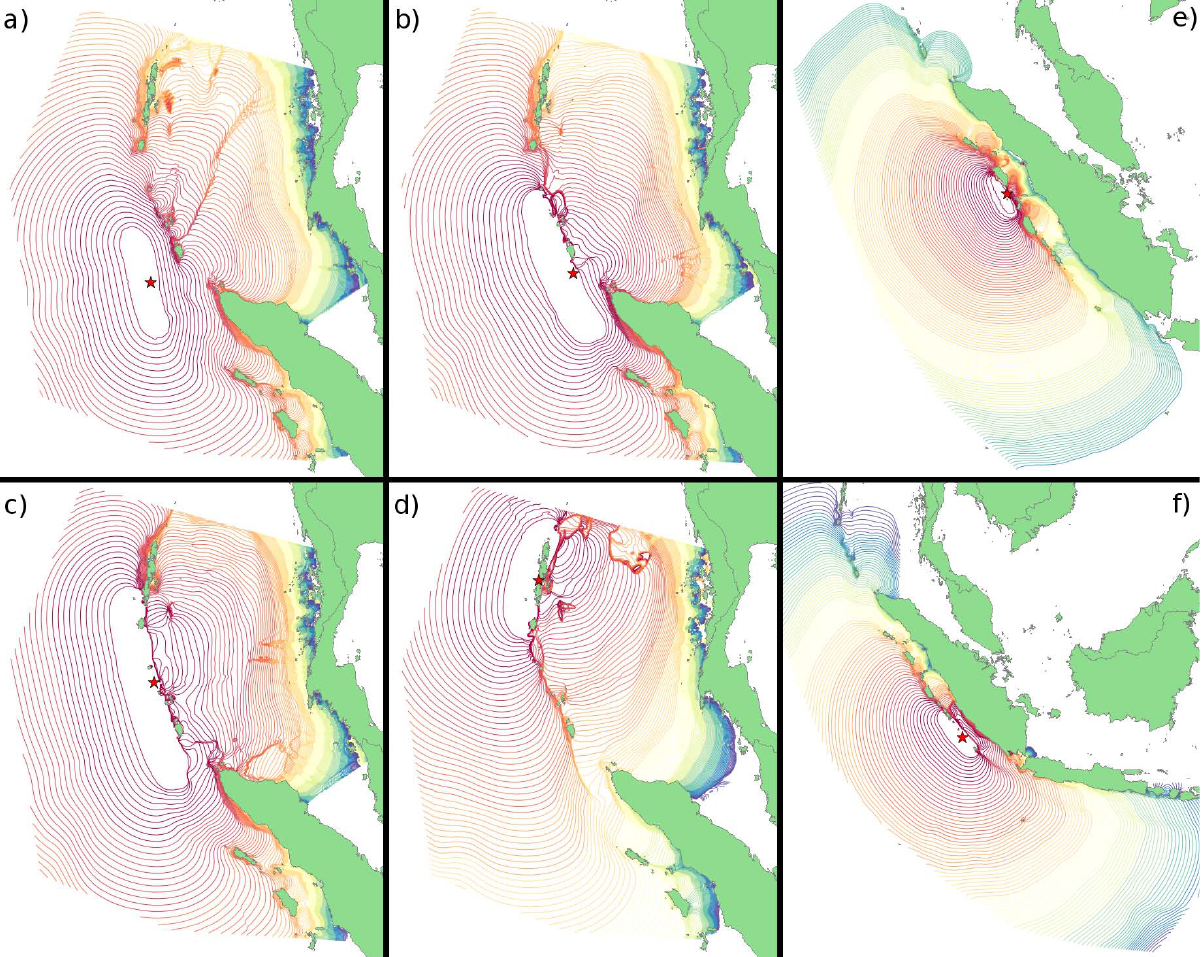
Fig. 3. Virtual scenarios selected in 2009 for testing, demonstration and validation of Thai system (a–d) and Indonesian system (e–f) with tsunami wave propagation generated by earthquake events: (a) 92.81 ◦ E, 5.94 ◦ N, M w = 8.0 and M w = 8.5; (b) 93.87 ◦ E, 6.26 ◦ N, M w = 8.0 and M w = 8.5 and M w = 8.8; (c) 92.93 ◦ E, 8.65 ◦ N, M w = 8.0 and M w = 8.5 and M w = 9.0; (d) 92.67 ◦ E, 12.21 ◦ N, M w = 8.0 and M w = 8.5; (e) 97.82 ◦ E, 0.19 ◦ N, M w = 8.0; (f) 101.28 ◦ E, 4.55 ◦ S, M w =